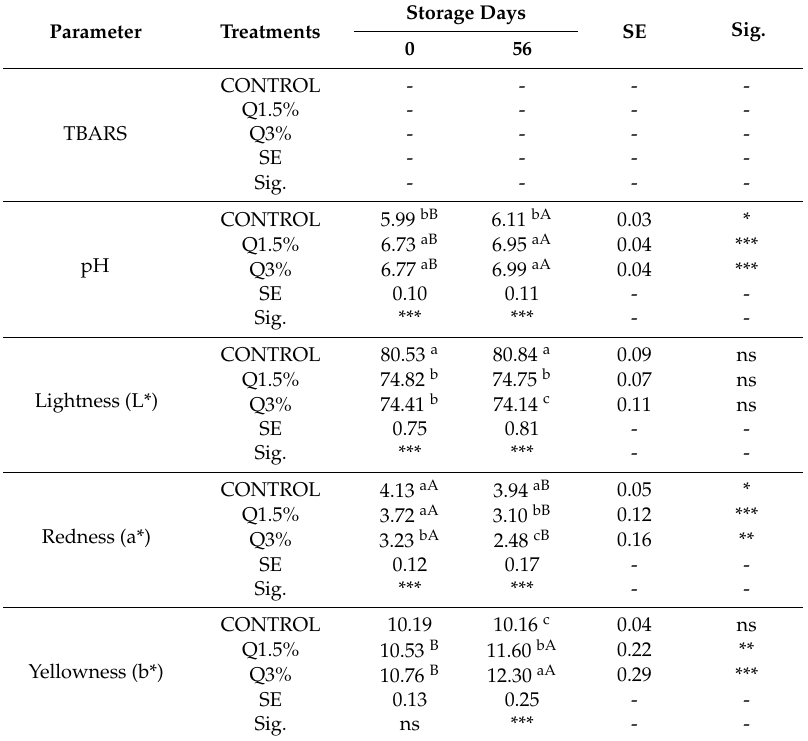
Table 3. E ff ect of the chitosan inclusion on lipid oxidation (TBARS), pH, and color parameters of low-fat cooked sausages made from turkey meat a ff ected by white striping